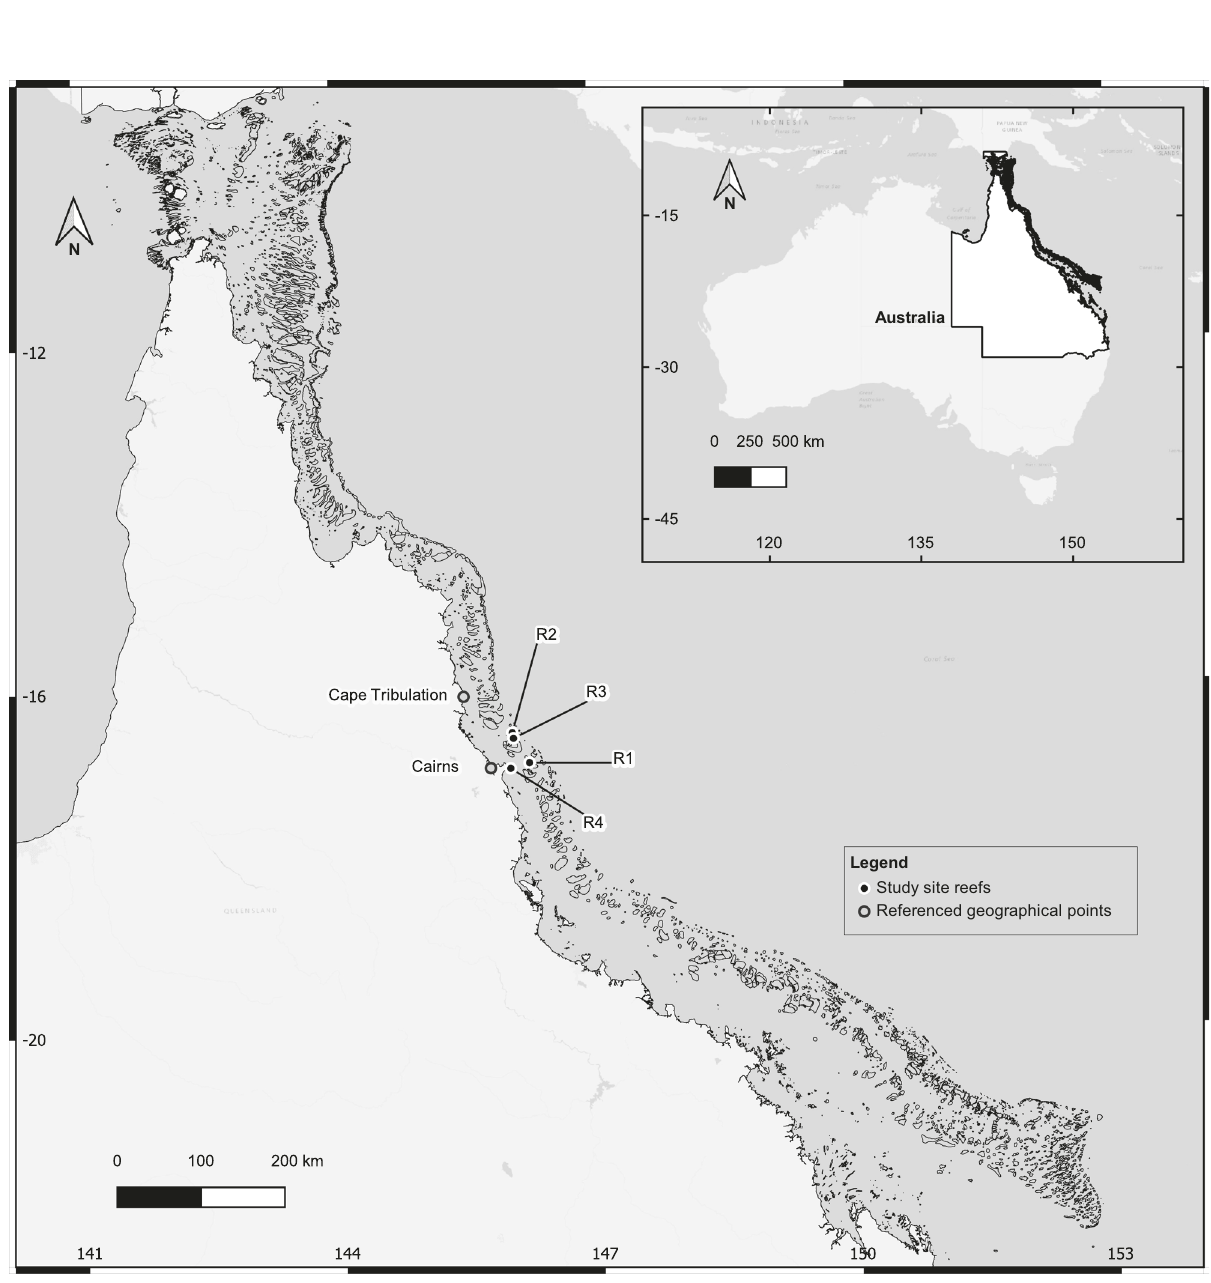
Fig. 2 Study sites on Australia ’ s Great Barrier Reef (GBR). Map delineating reefs on which management control sites used in this study were located and key geographical points referenced in this study. Pre fi x “ R ” denotes reef, for example, R1 is reef 1. Developed in QGIS with GBR features dataset 113